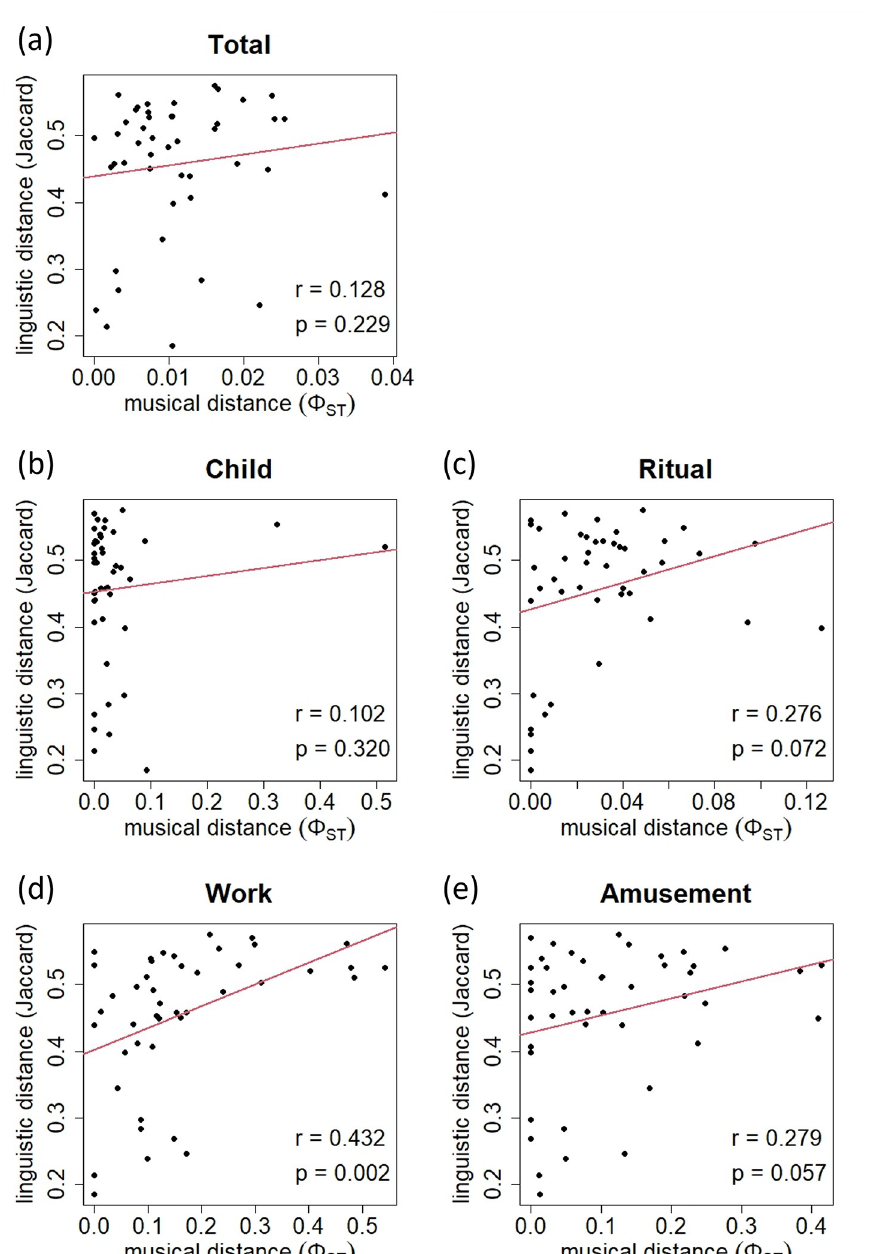
Fig 5. Regression plots. Regression plots for songs of (a) all social contexts pooled, (b) "child," (c) "ritual," (d) "work," and (e) "amusement" versus languages in the ten islands for which linguistic data were available. There was significant correlation between songs of "work" and